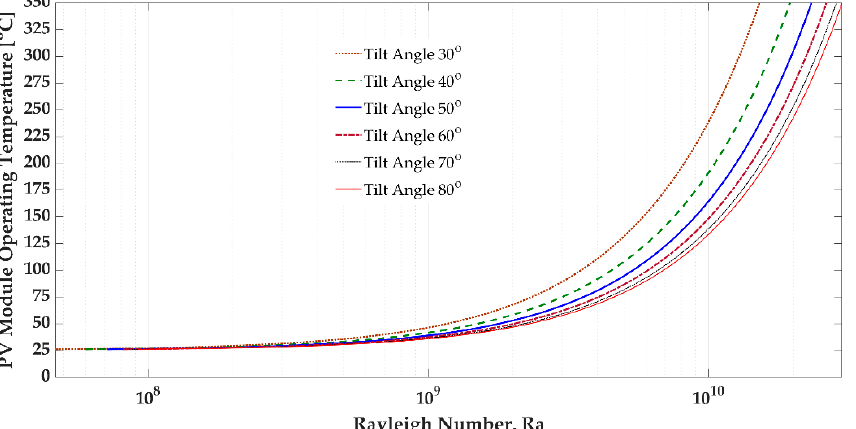
Figure 4. Rayleigh number variation on inclined PV module operating temperature, with various solar fluxes at γ = 90° and 30° ≤ θ ≤ 80°.